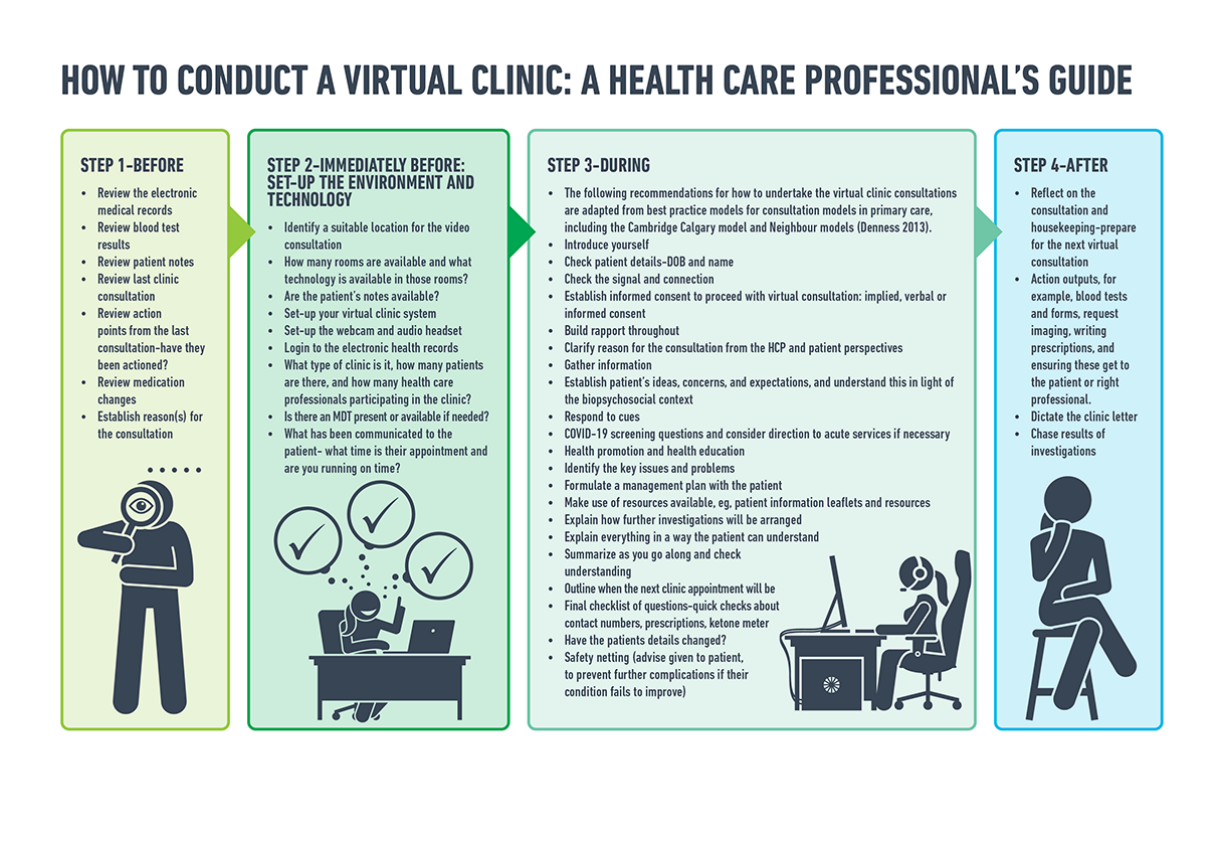
Figure 2. How to conduct a virtual clinic: a health care professional's guide. MDT: multidisciplinary team; DOB: date of birth; HCP: health care professional; COVID-19: coronavirus